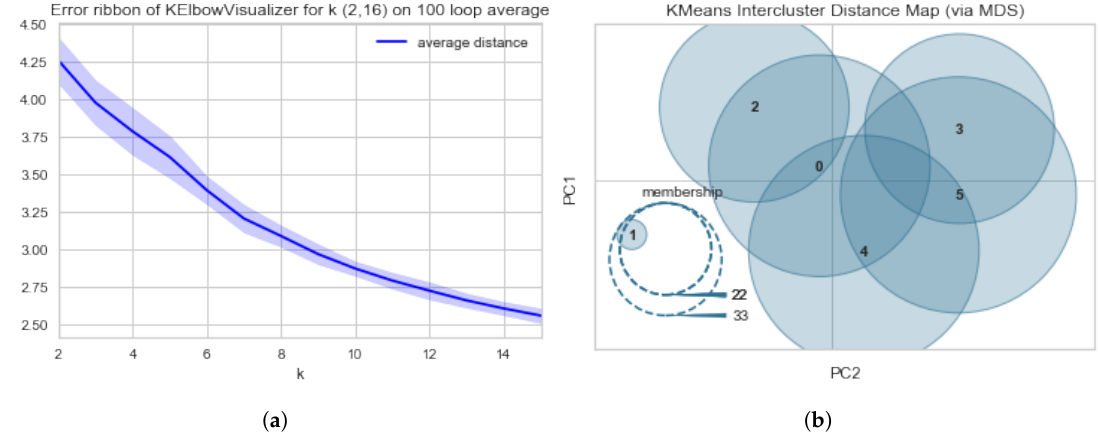
Figure 1. Diagrams of the Elbow–Knee scores and errors using Calinski Harabasz method. ( a ) Diagram of the Error Ribbon for the Elbow–Knee Plots using Calinski Harabasz method with cluster size ( k ) ranging from 2 to 16. ( b ) Diagram of Intercluster Distance Map using YellowBricks Calinski Harabasz method with cluster size ( k ) =